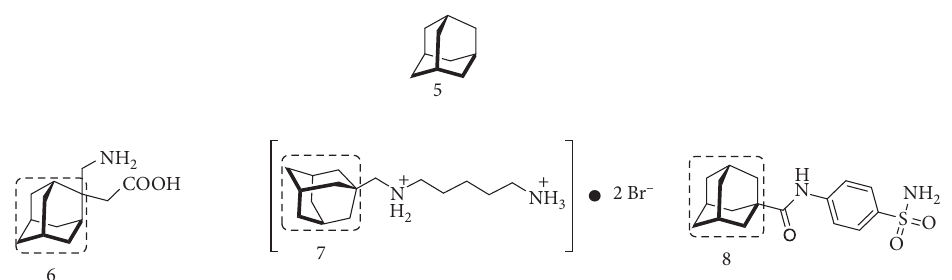
Figure 2: Chemical structure of adamantane derivatives reported with promising anticonvulsant